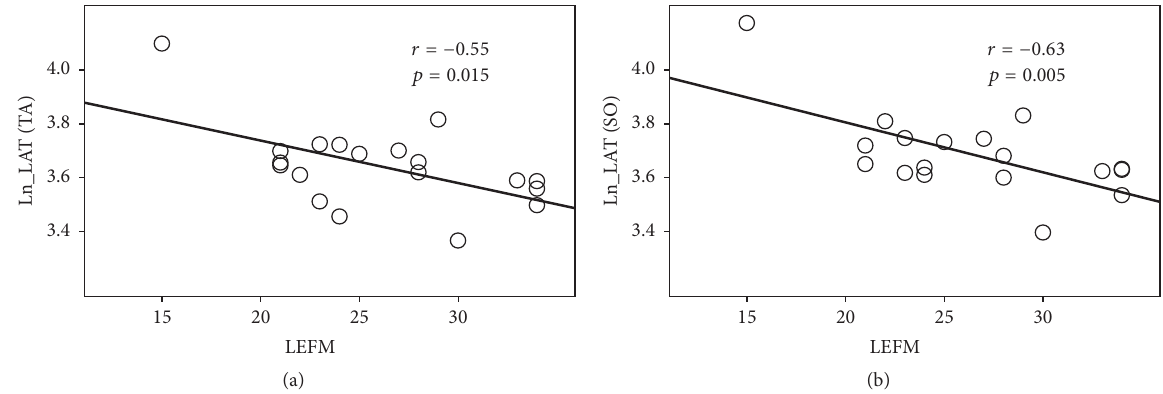
Figure 2: Plot of latency versus LEFM for SO and TA (Ln LAT versus LEFM score). (a) Ln LAT at TA. (b) Ln LAT at SO.